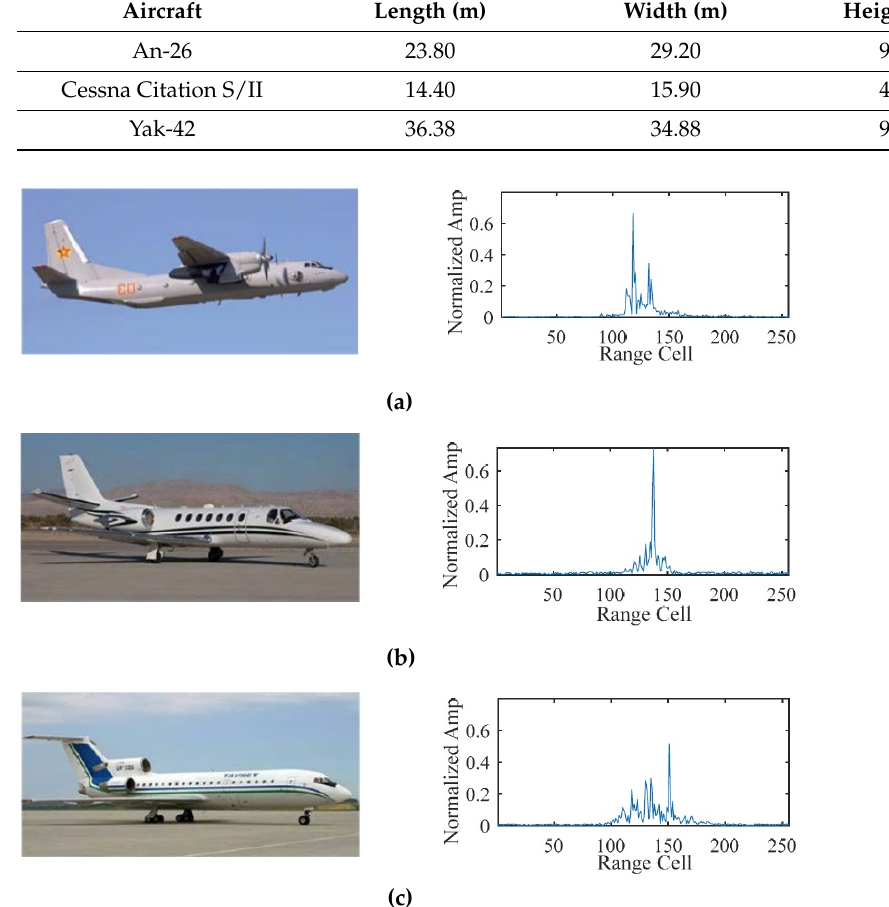
Figure 6. Optical images and typical HRRPs of ( a ) An-26; ( b ) Cessna Citation S/II; ( c ) Yak-42.